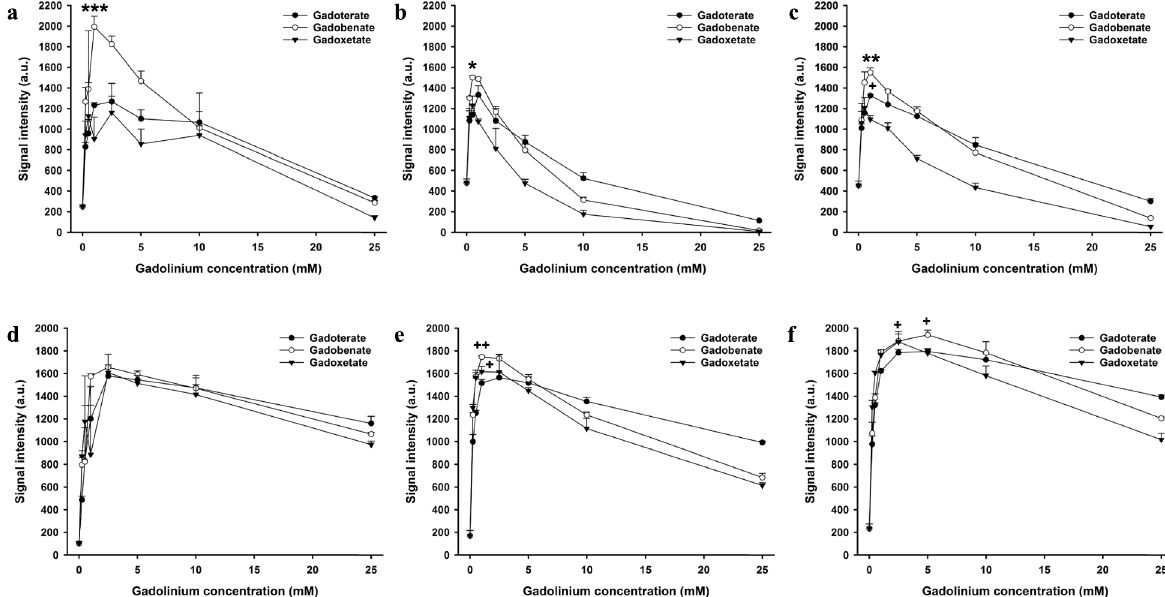
Fig. 2 Signal intensities of gadoterate, gadobenate, and gadoxetate in saline and biological fluids on T1‑weighted spin‑echo and turbo field‑echo MRI. Signal intensities of gadoterate, gadobenate, and gadoxetate at different concentrations in saline ( a ), blood ( b ), and bile ( c ) on T1‑weighted spin echo MRI. Signal intensities of gadoterate, gadobenate, and gadoxetate at different concentrations in saline ( d ), blood ( e ), and bile ( f ) on T1‑weighted turbo field‑echo sequence. * significantly higher maximum signal intensity of the contrast agent than both other contrast = agents; significantly higher maximum signal intensity than the contrast agent with the lowest maximum signal intensity. * or + = or p < 0.010; *** or p < + + = + + + =